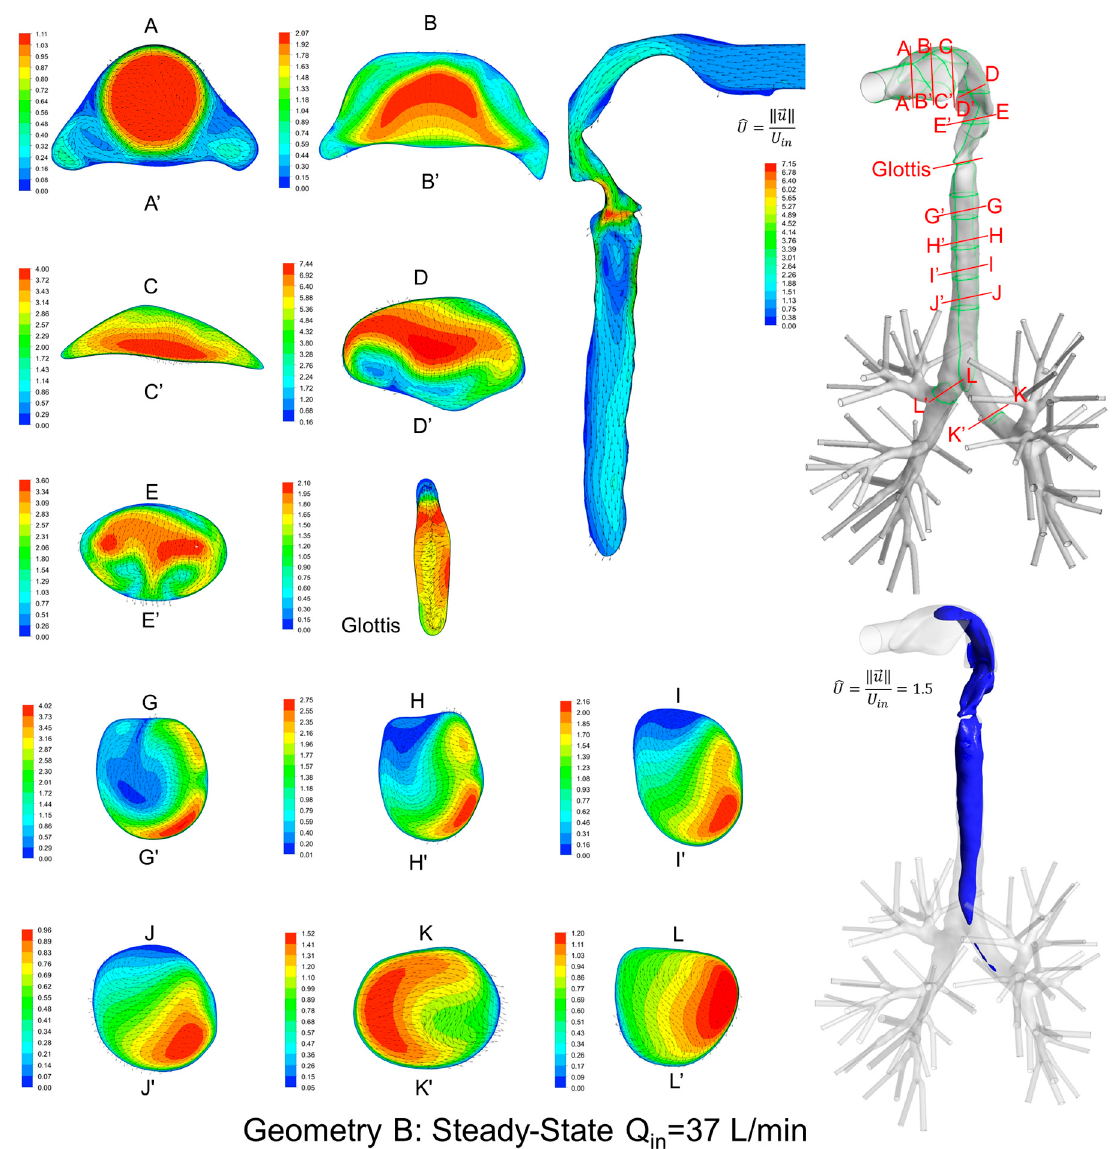
Figure 7. Dimensionless velocity distributions and laryngeal jet core at multiple cross-sections and the sagittal plane of Geometry B under a steady-state inhalation flow rate of Q in = 37 L/min.